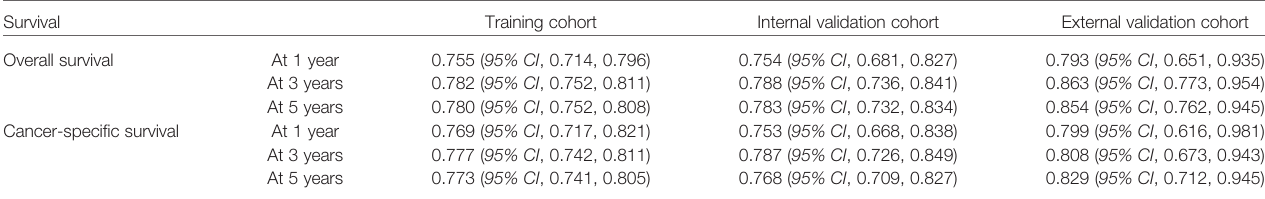
TABLE 4 | AUC for the nomogram in patients with RPLs.